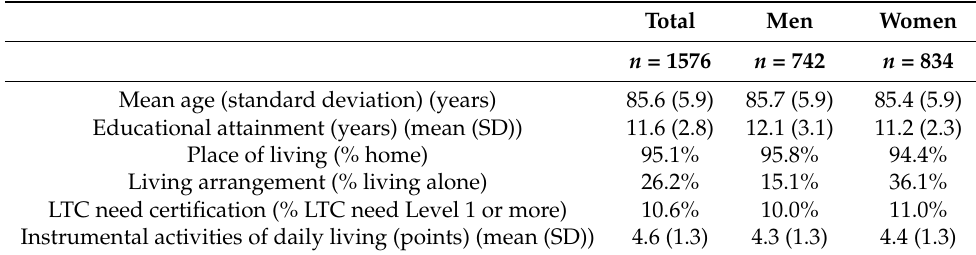
Table 2. Basic characteristics of the analyzable